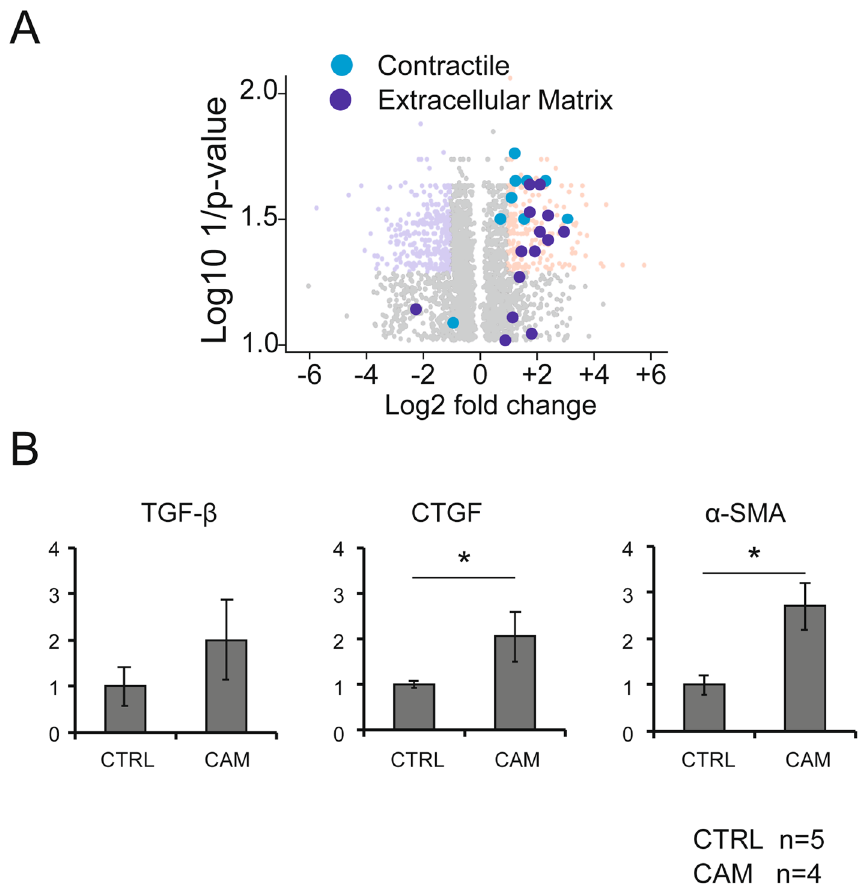
Figure 2. ( A ): Genes related to the contractile apparatus (light blue) and extracellular matrix (deep blue), were plotted on the volcano plot. ( B ): Real time analysis of the myofibroblast marker genes, the CAM group: n = 4, and the non CAM group (CTRL): n = 5, * p < 0.05, Error bars indicate ± SE, Mann–Whitney analysis was used for statistical